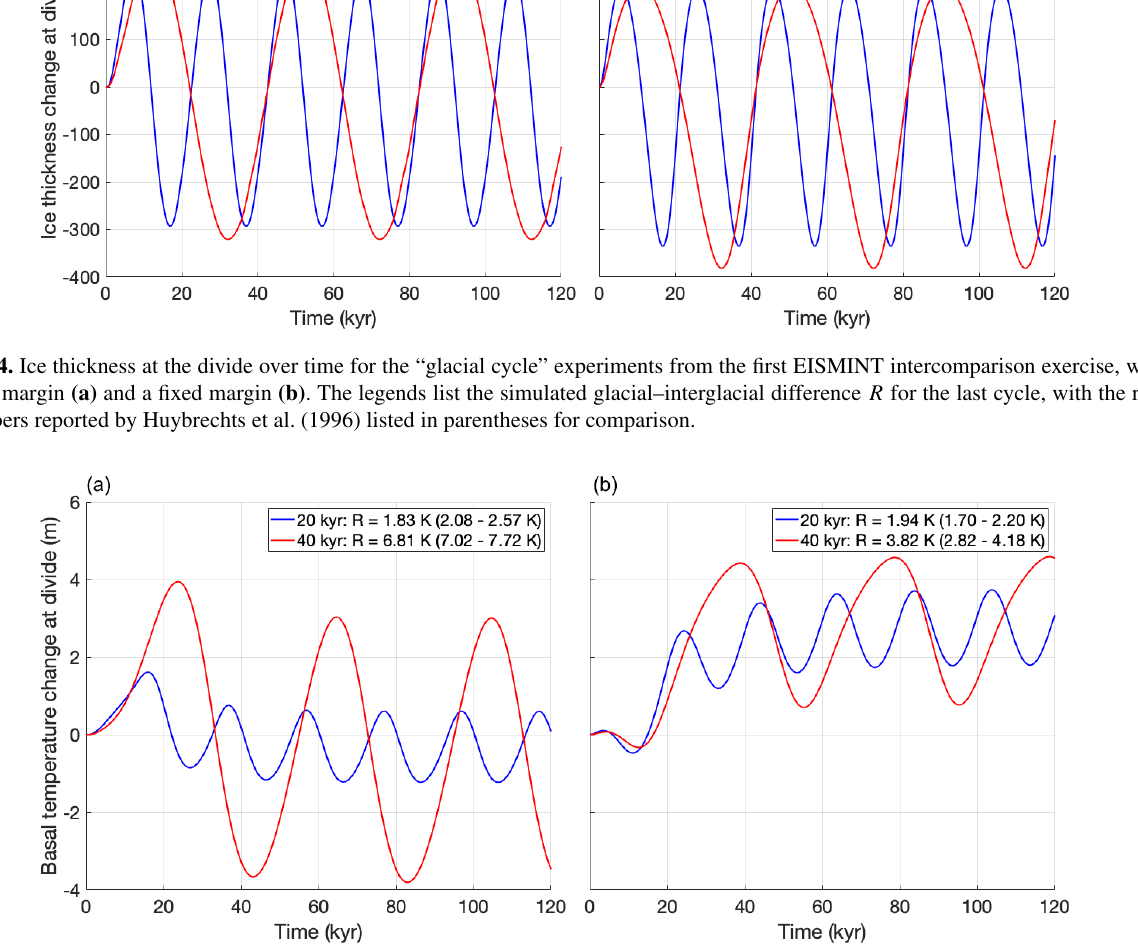
Figure 5. Ice temperature at the base of the ice divide, relative to the pressure melting point, over time for the “glacial cycle” experi- ments from the first EISMINT intercomparison exercise, with a moving margin (a) and a fixed margin (b) . The legends list the simulated glacial–interglacial difference R for the last cycle, with the range of numbers reported by Huybrechts et al. (1996) listed in parentheses for